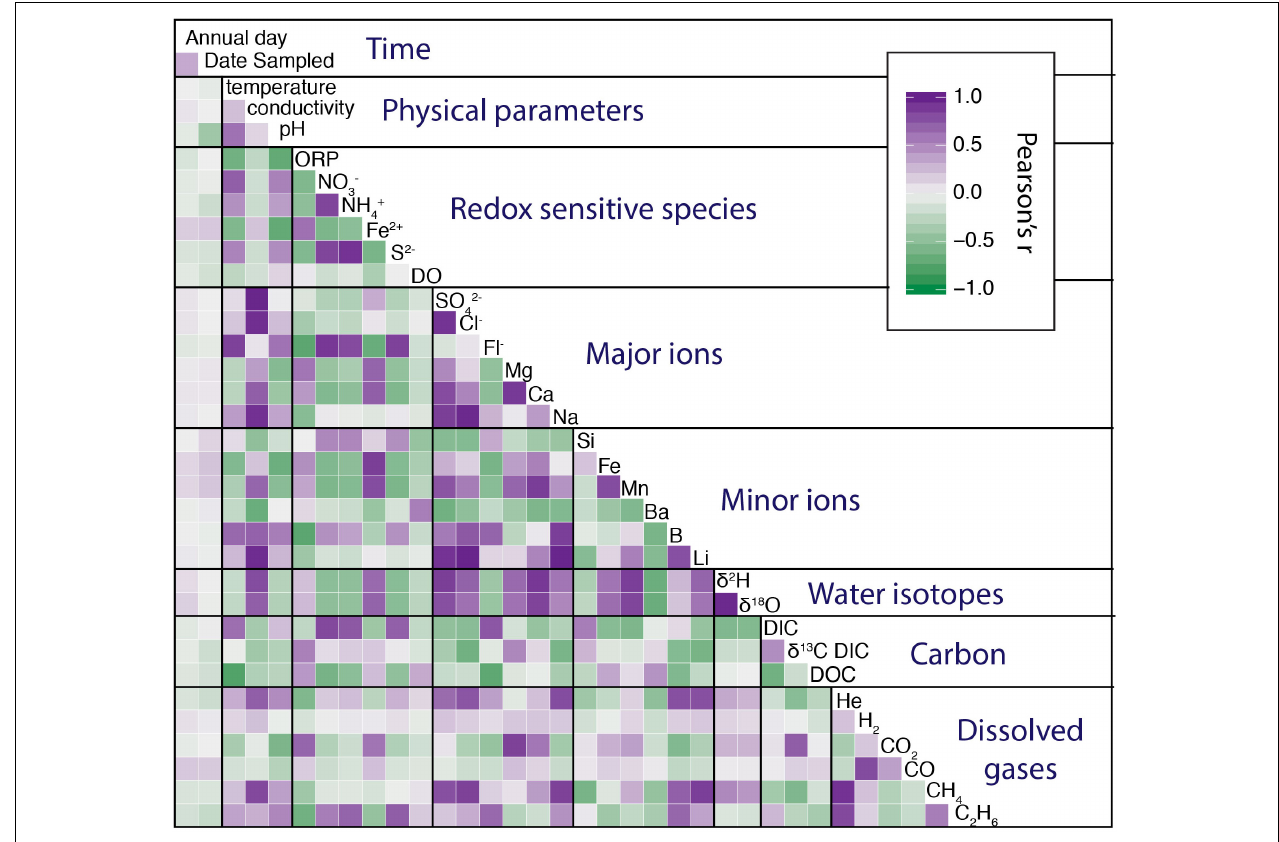
FIGURE 9 | Correlogram of all geochemical data showing Pearson’s r correlation between variables with color. Correlogram was generated with GGally r